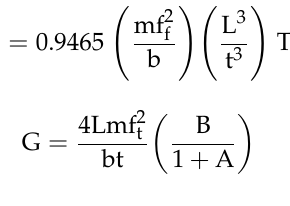
Figure 4. Digital Injection Moulding Machine.